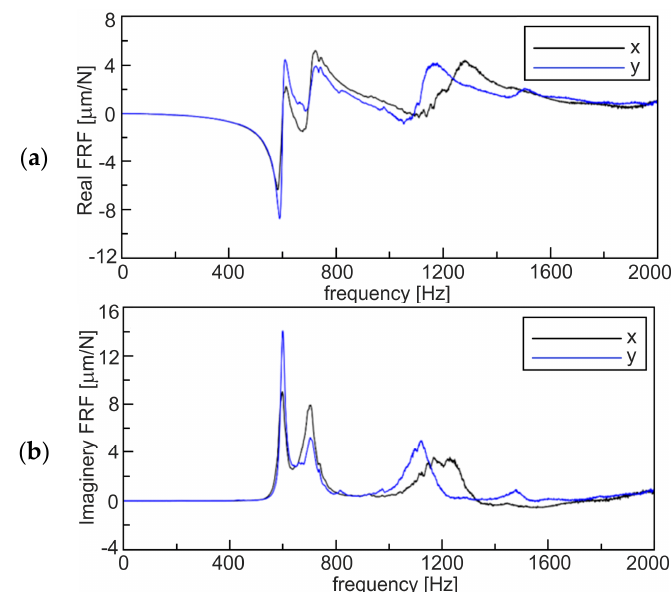
Figure 2. Frequency response function (FRF) of the tool-holder system. Real ( a ) and imaginary part ( b ).